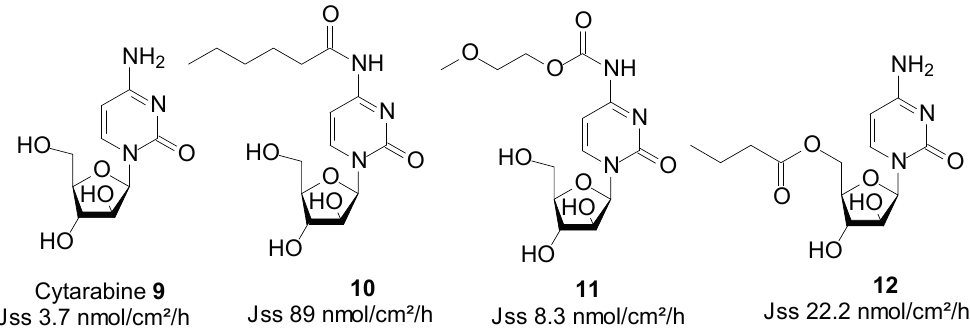
Figure 4. Cytarabine and its best skin permeant